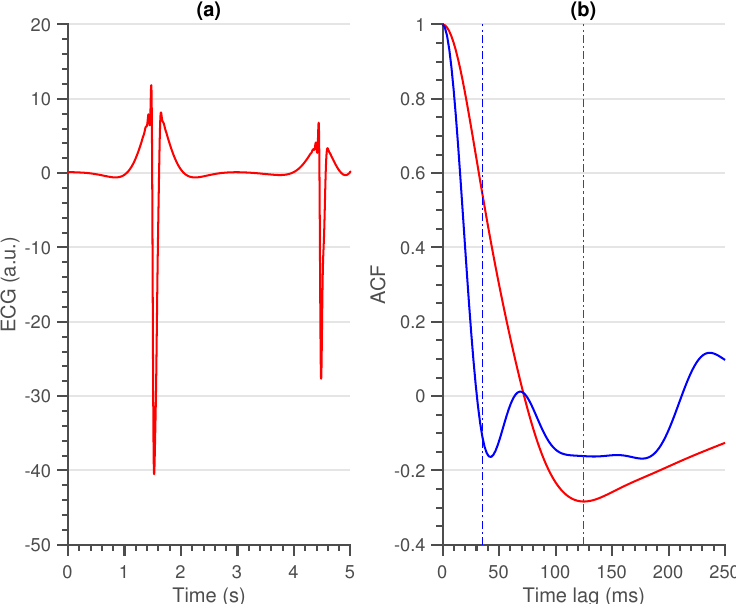
Figure 2. ( a ) An electrocardiogram (ECG) segment that contains a large artefact. ( b ) The respective ACF of the ECG segment (red), together with the ACF of the clean non-contact segment (blue) of Figure 1. The dotted red line in plot indicates the first local minimum and the dotted blue line indicates maximum amplitude at 35